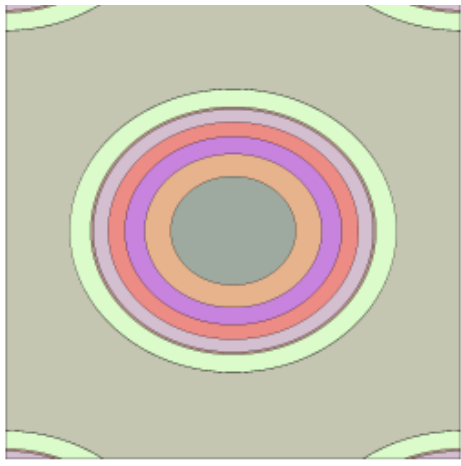
Figure 3. Fuel pin model from the Serpent code. The cladding and pellet are divided into several concen- tric rings to allow high precision of the simulation of isotopic changes.